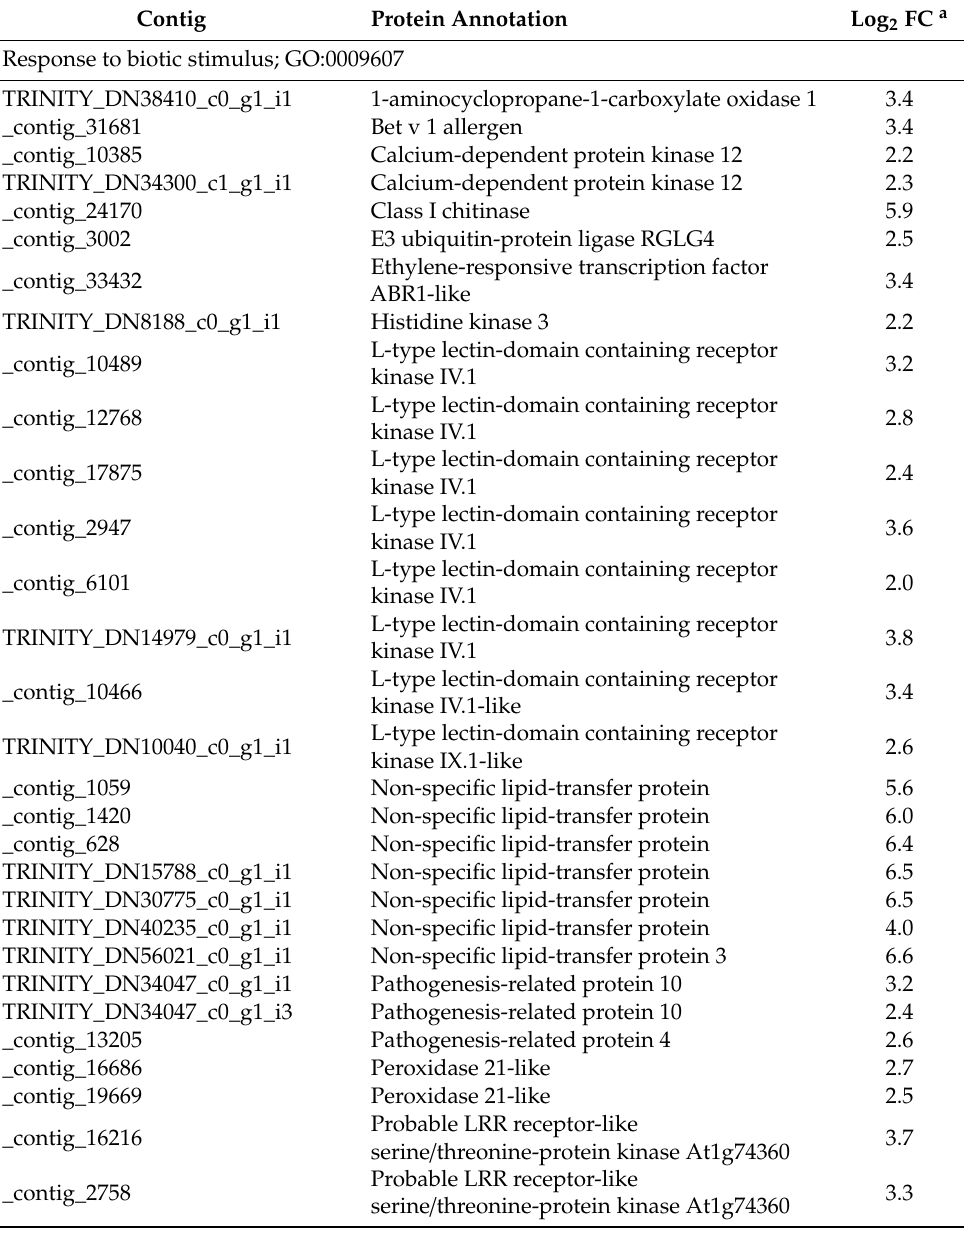
Table 11. Up-regulated plant genes in the choke stroma tissues in the gene ontology (GO) categories of response to biotic stimulus and response to water deprivation (false discovery rate <